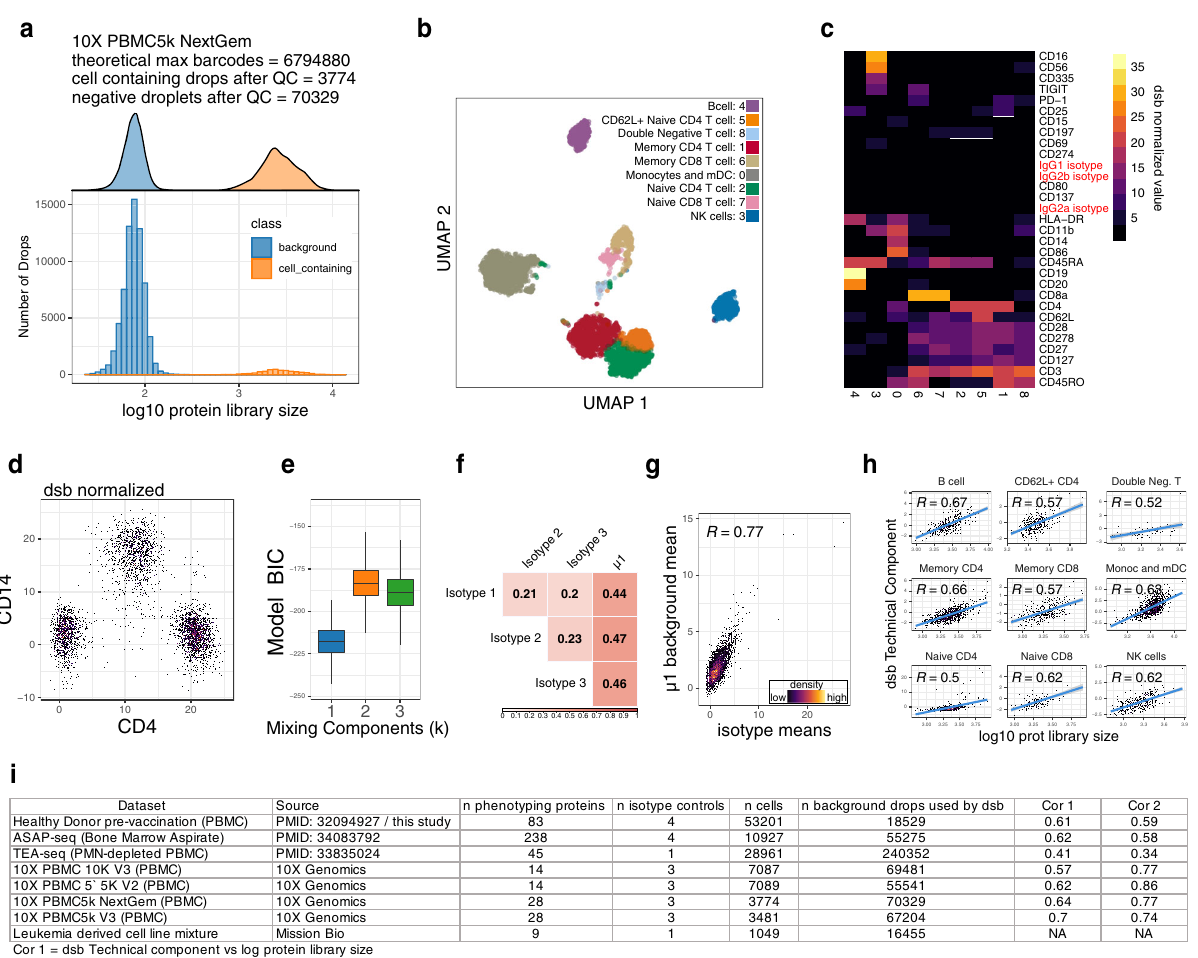
Fig. 2 Assessment of dsb model assumptions and performance of dsb normalization on external datasets. Panels a – h Application of dsb to a publicly available dataset generated using 10X genomics “ NextGem ” chemistry measuring 29 proteins across ~5K cells. a The protein library size distribution of empty and cell-containing droplets used for dsb normalization. b UMAP of single cells based on dsb normalized protein values with colors representing clusters obtained from clustering cells on dsb normalized protein values. c Heatmap of the average of dsb normalized values per protein-based cluster shown in ( b ). d The distribution of CD14 and CD4 dsb normalized values. e As in Fig. 1e, Gaussian mixture model parameters fi t to the dsb normalized values of each single cell after step I (ambient noise/background droplet based correction). The Bayesian Information Criterion (BIC) of the model vs. number of components in the model fi t for each cell ( n = 3774 cells). Boxplots show the median with hinges at the 25th and 75th percentile and whiskers extending plus or minus 1.5 times the inter quartile range. f As in Fig. 1f, Pearson correlation coef fi cient matrix of variables used to de fi ne each cell ’ s technical component; each isotype control and µ 1, the Gaussian mixture model background mean across proteins for each cell. g As in Fig. 1g, Pearson correlation coef fi cient between the inferred cell-speci fi c background mean µ 1 from the Gaussian mixture model vs. the mean of isotype controls in each cell. h The relationship between each cell ’ s technical component and the cell ’ s protein library size (Pearson correlation coef fi cient shown as in Supplementary Fig 3a with 95% con fi dence interval in gray). i Summary statistics for the eight independent datasets assessed in this study; Cor 1 and 2 correspond to the Pearson correlation coef fi cient for assessing the relationships between variables shown in ( h ) and ( g ) across cells for each